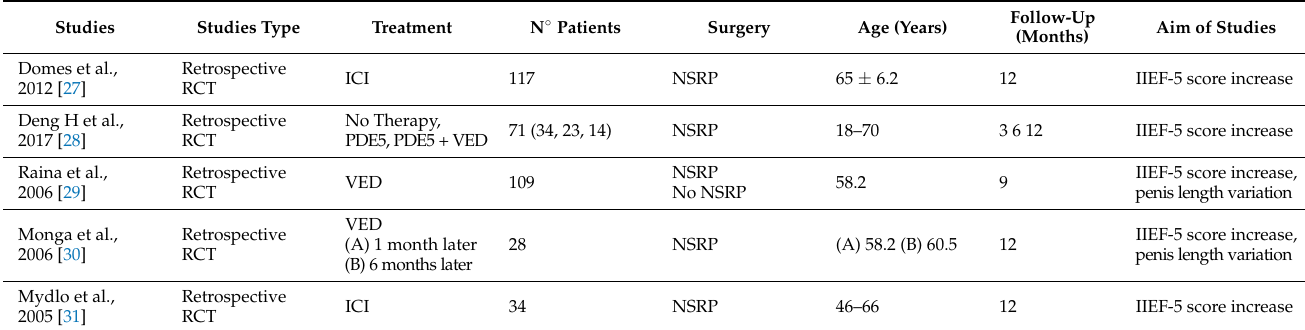
Table 2. Characteristics of the VED and ICI studies